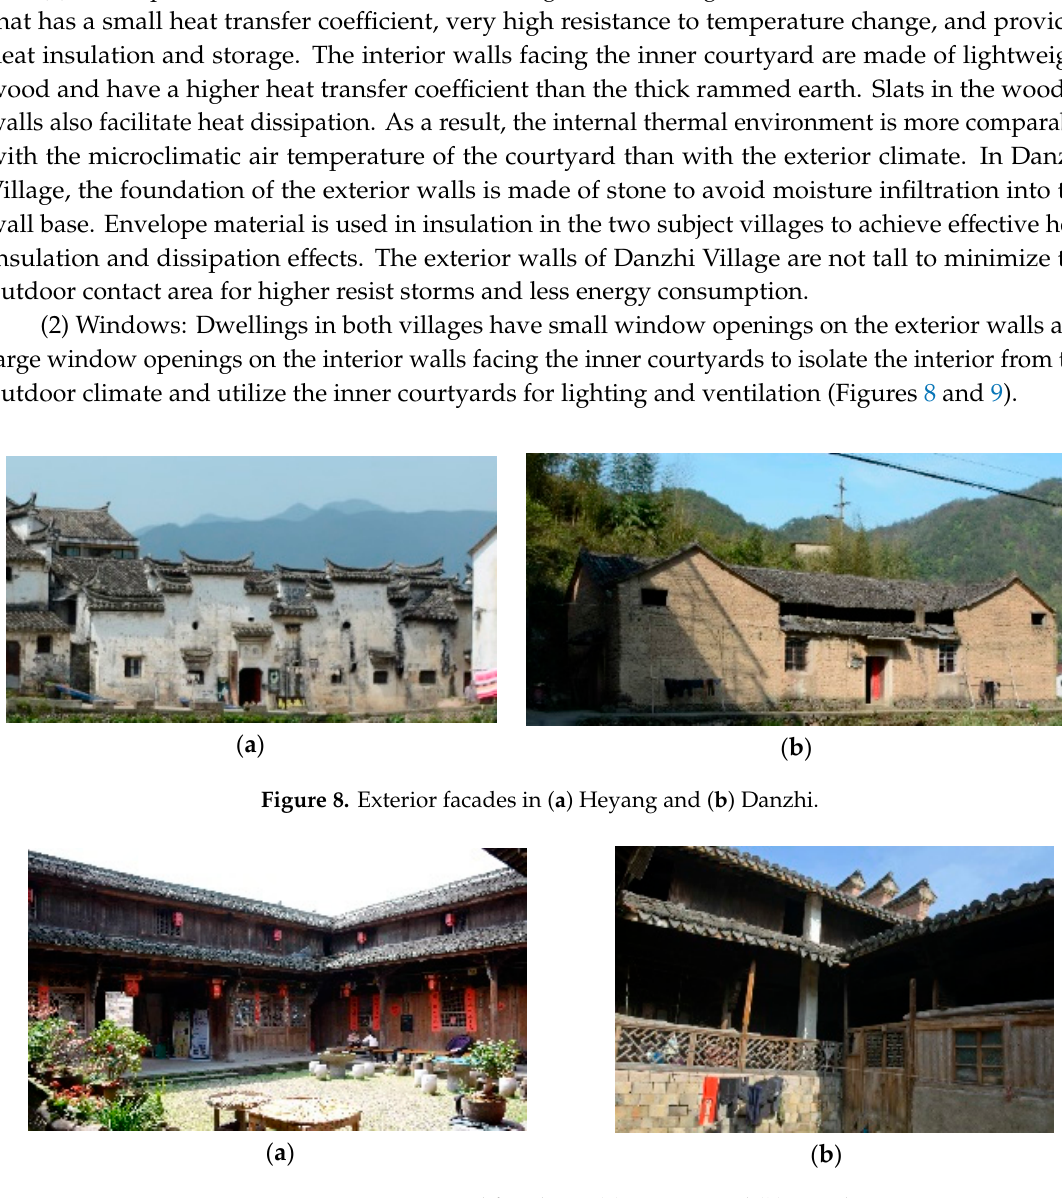
Figure 7. Building sections in ( a ) Heyang and ( b ) Danzhi.